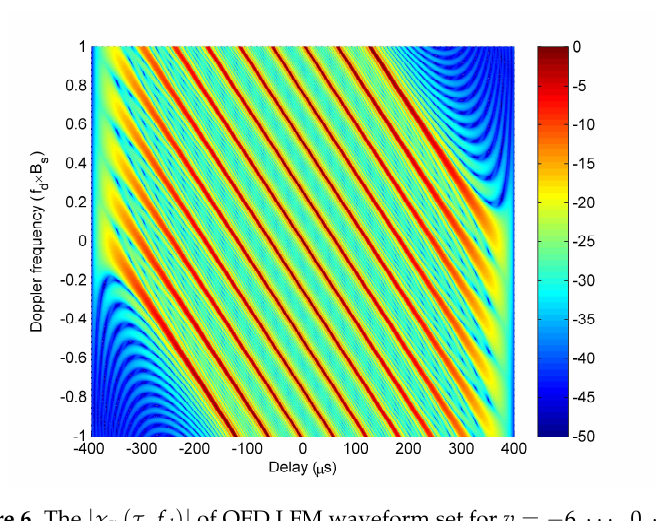
Figure 6. The | χ v ( τ , f d ) | of OFD LFM waveform set for v = − 6, · · · ,0, · · ·